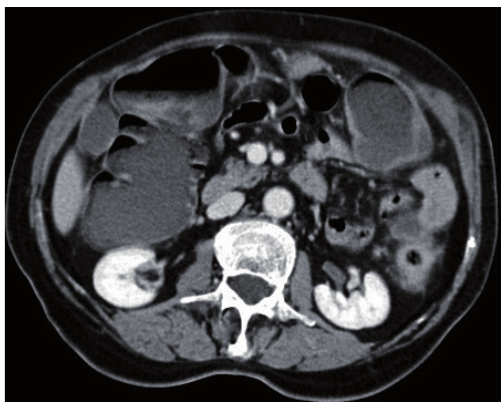
Figure 1: CT scan of abdomen in a patient with obstructing carci- noma of the sigmoid colon.